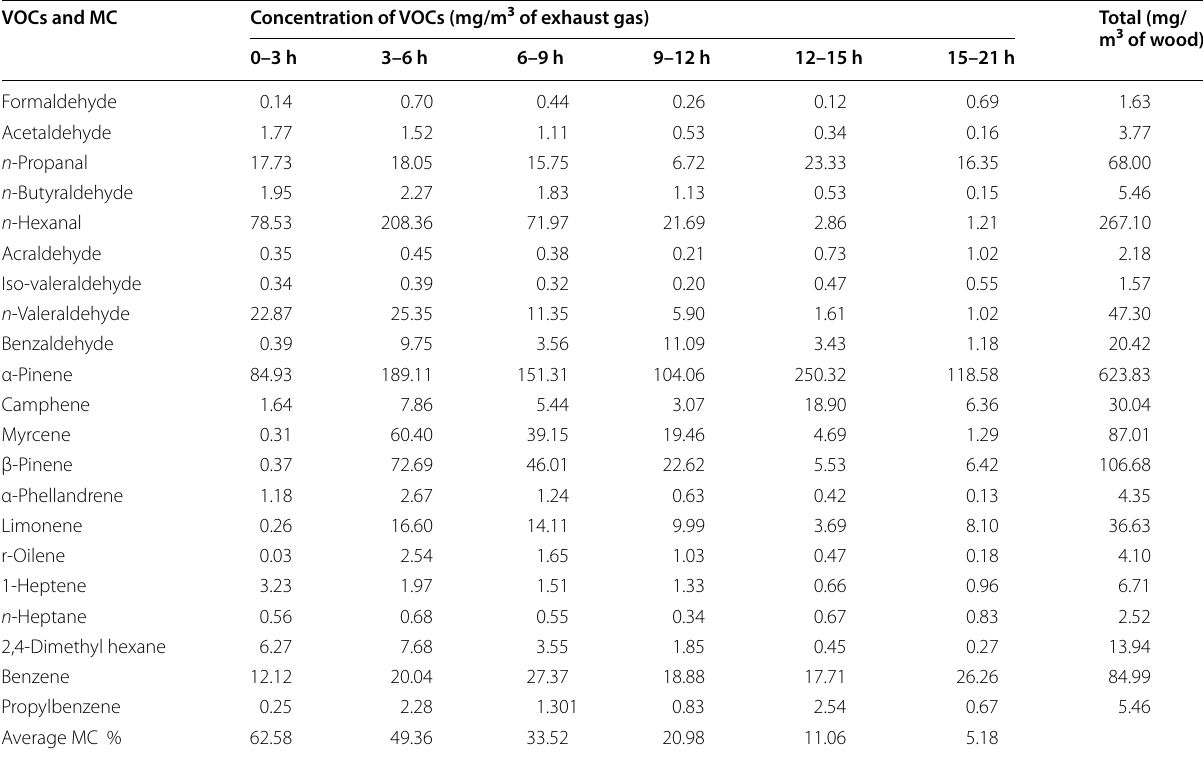
Table 3 Constituents and amount of VOCs released during each period of high-temperature drying (plantation P. sylvestris ) VOCs and